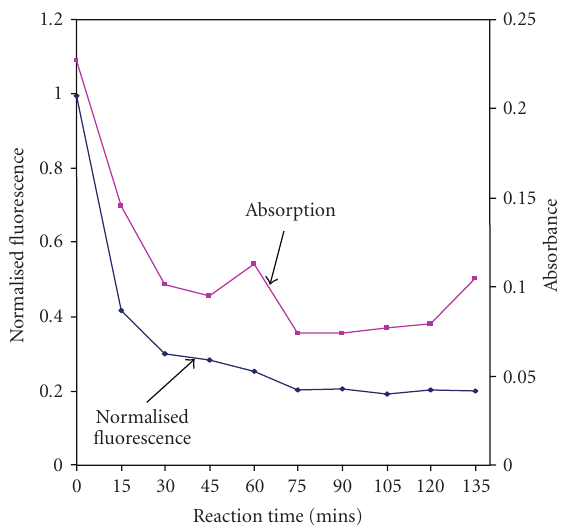
Figure 3: Demonstration of the decrease in both absorbance and fluorescence activity of produced water with reaction